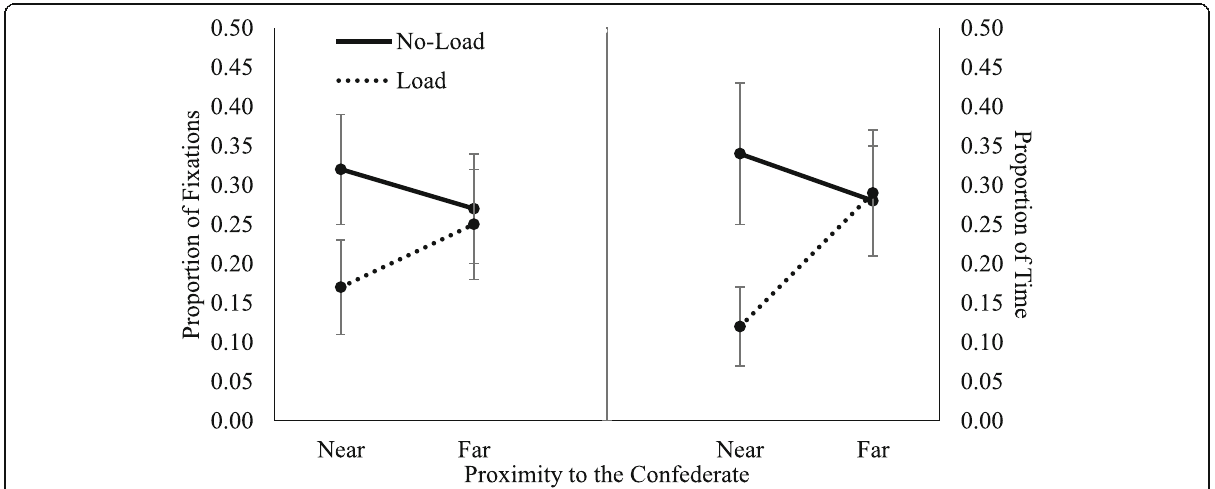
Fig. 3 The mean proportion of fixations (left panel) and time spent on the confederate (right panel) when the confederate was in view for Condition (no-load, load) and Proximity (near, far) in Experiment 2. Bars show 95% confidence intervals